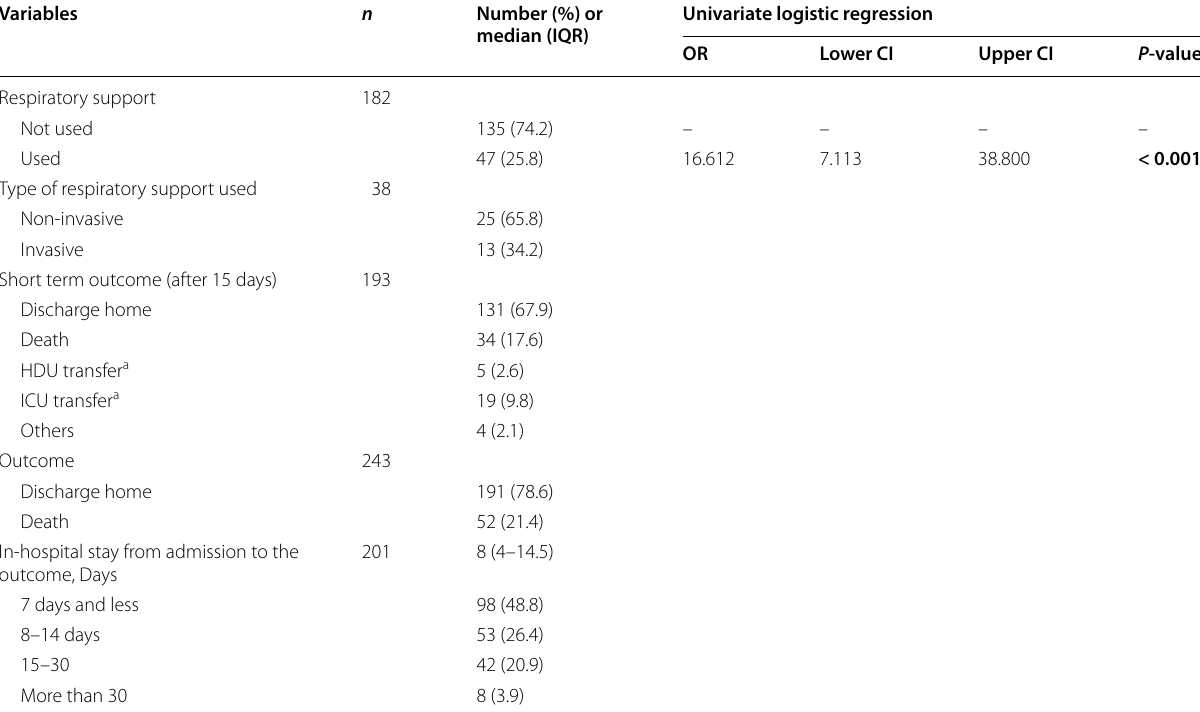
Table 4 Respiratory support and outcomes of patients diagnosed with COVID-19 and the association of respiratory support with final